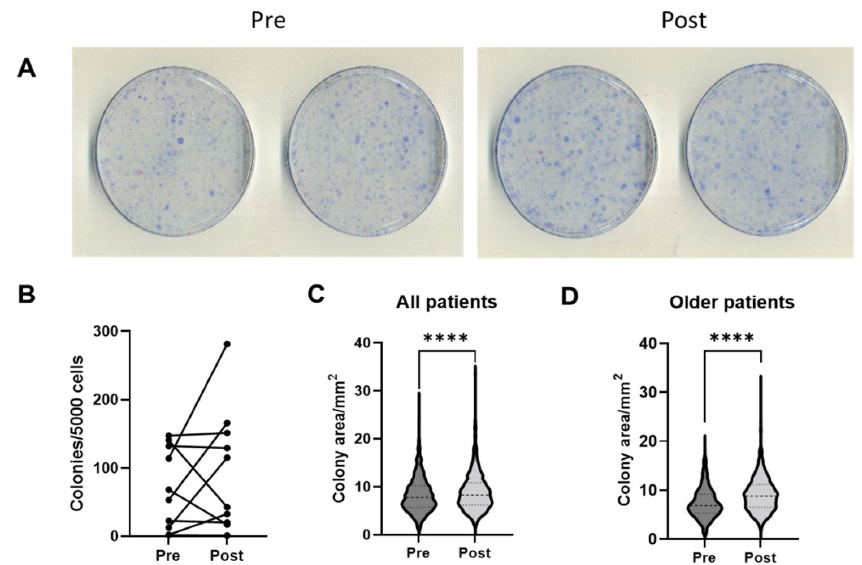
Figure 1. Colony-forming capacity in p1 MSCs before (Pre) and 2 weeks after (Post) PRP infiltrations (n = 10 patients, symbols represent averages of the duplicate dishes). ( A ) Images of duplicate dishes from a representative patient. ( B ) CFU-F frequencies in the Pre and Post samples. ( C ) Violin plots showing the colony area distributions in all patients. ( D ) Violin plots showing the colony area distributions in older (>60 years old) patients. **** p < 0.0001, Mann–Whitney U test.